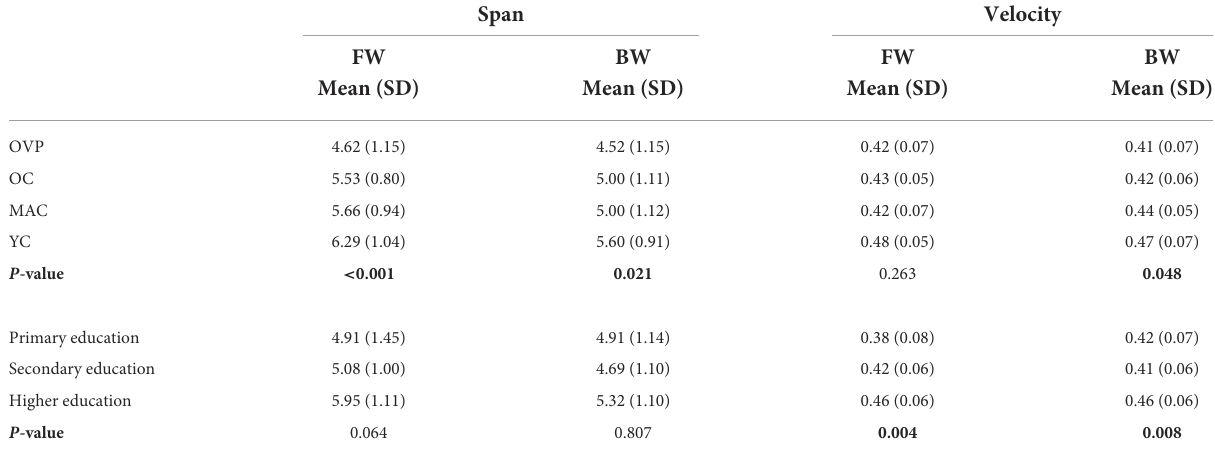
TABLE 2 Comparison of weeding test indexes between